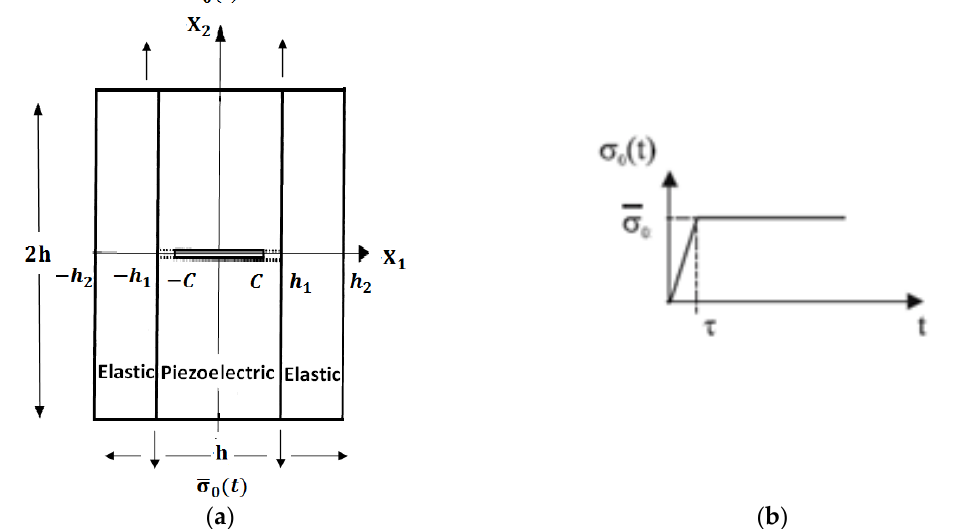
Figure 3. Schematic of ( a ) the Lead-Zirconium-Titanium oxide (PZT) cracked composite plate and ( b ) the applied stress.